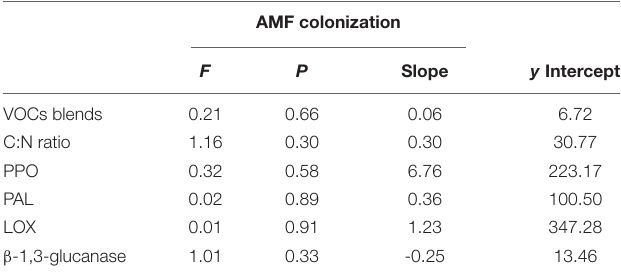
TABLE 2 | Results of linear model analyses of the effects of the availability of arbuscular mycorrhizal fungi (AMF) inoculum on volatile organic compounds (VOCs) blends, C:N ratio, and defense